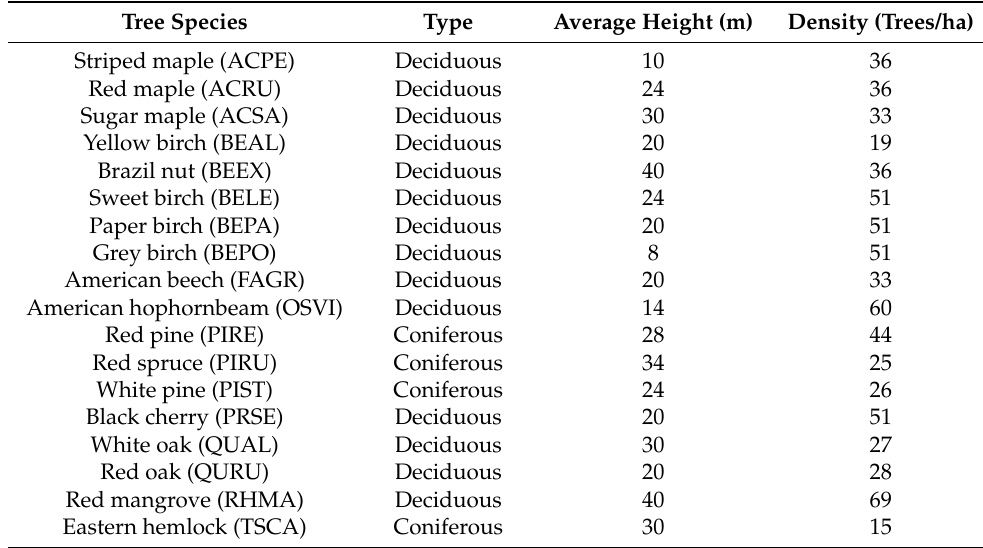
Table 1. Parameters of the simulated forest stands.